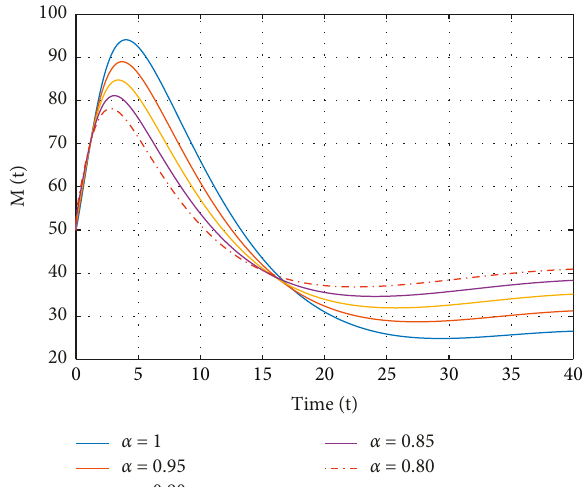
Figure 3: Schematic diagram for reaction process of methanol in the human